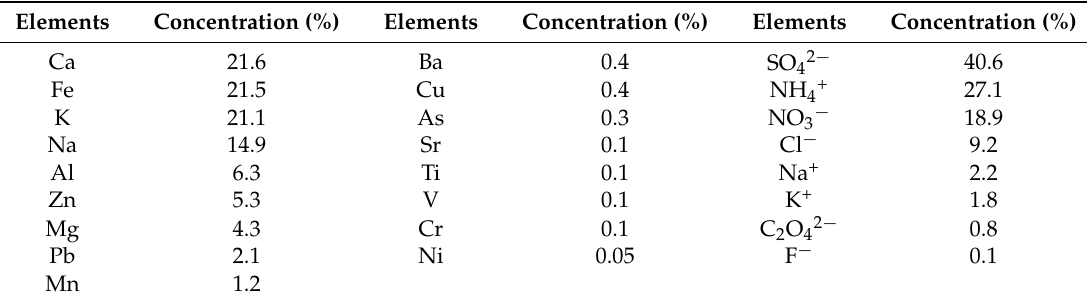
Table 2. Elemental and ionic concentration of PM 2.5